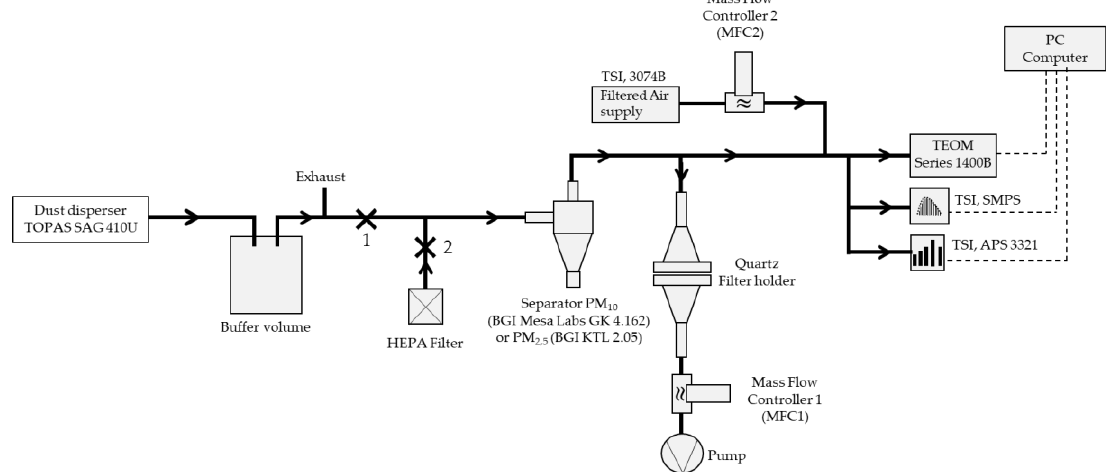
Figure 1. Experimental set-up for particulate matter (PM) 10 and PM 2.5 particulate filters loaded with incineration ash.